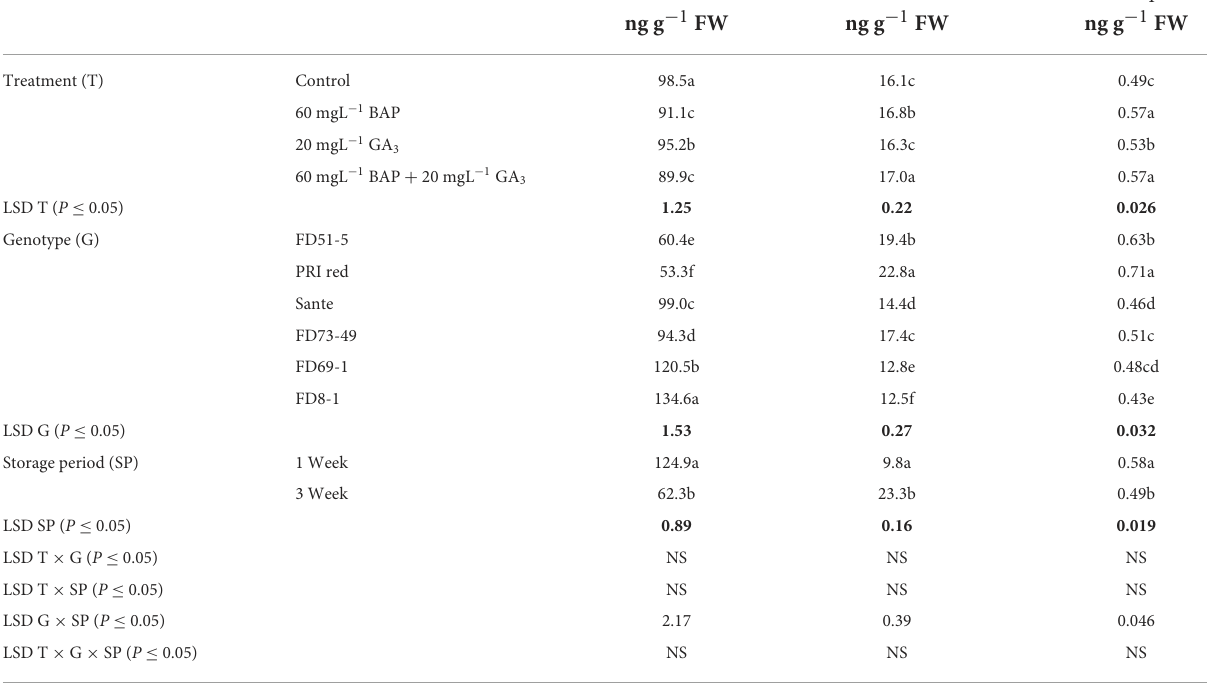
TABLE 2B Periodic changes in the contents of ABA, ZT, and GA 1 in experimental tubers of six potato genotypes dipped in optimized doses of PGRs during 2019. Factors